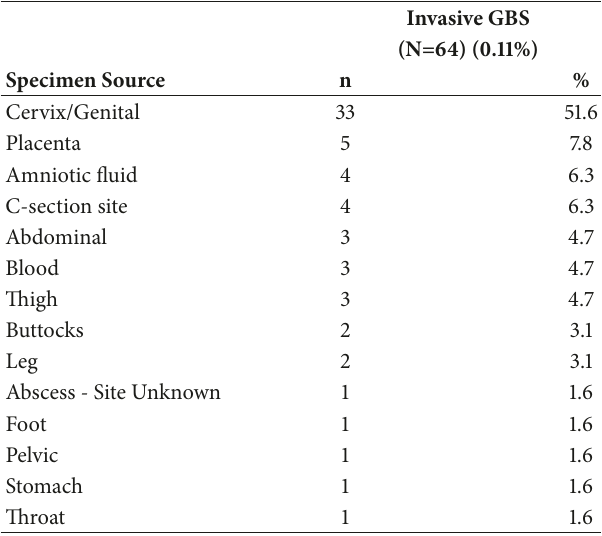
Table 4: Frequency of invasive GBS by specimen